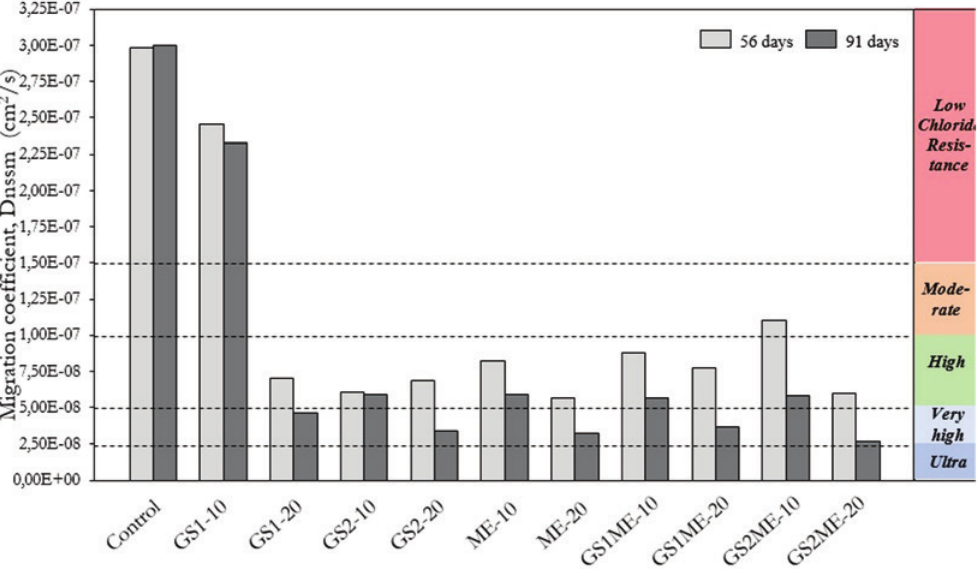
Non-steady-state chloride migration coefficient and chloride resistance